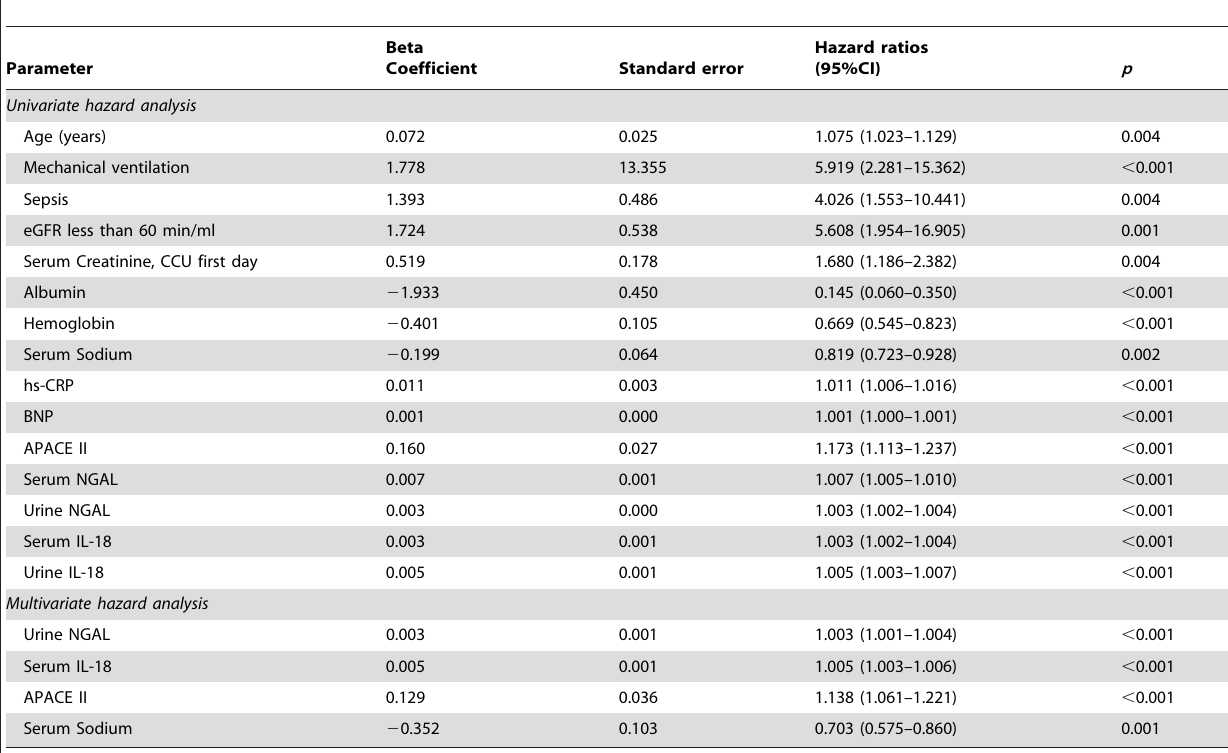
Table 5. Cox regression analysis for all-cause 6-month mortality, according to baseline prognostic factors on the first day of CCU admission.